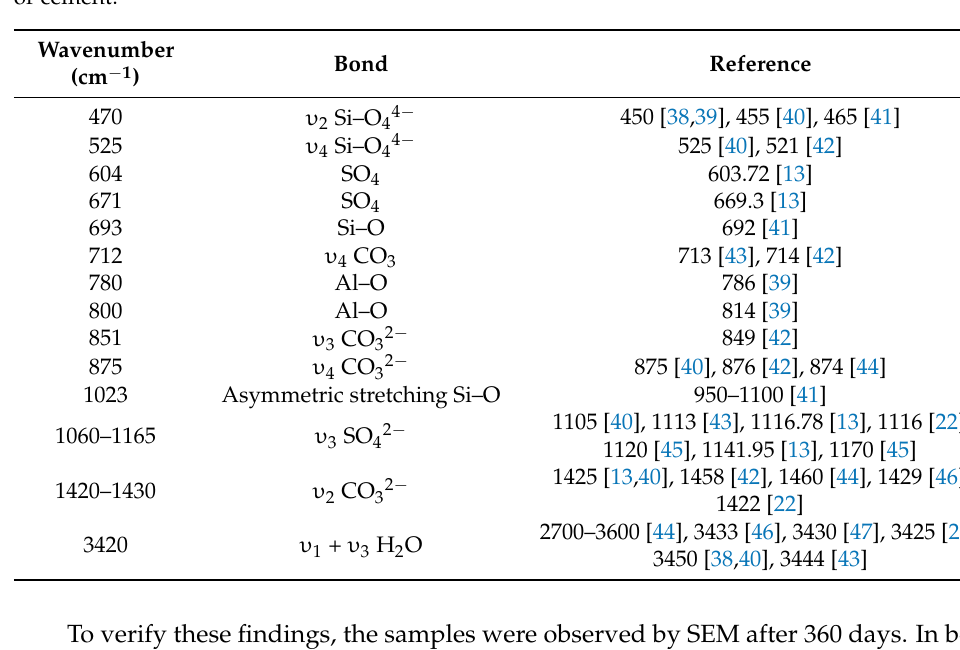
Table 6. Interpretation of peak positions observed in FTIR spectra of soil stabilized with WPFA or cement.